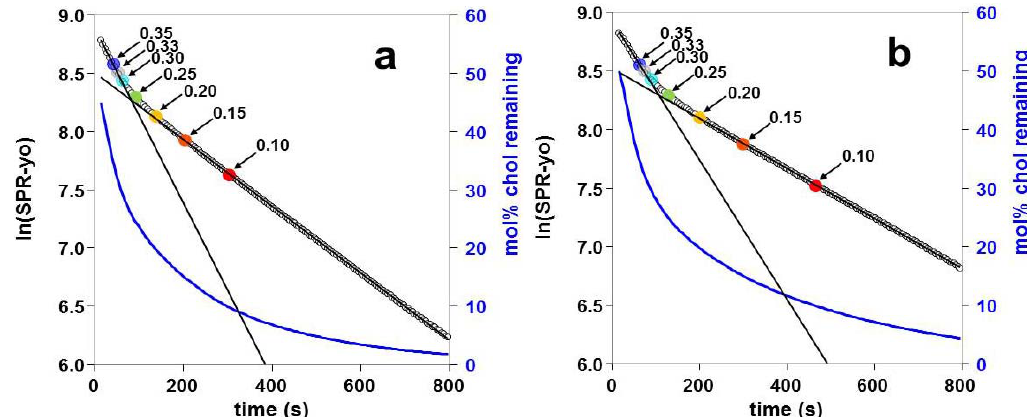
Figure 7. Kinetics of cholesterol removal from ( a ) POPC and ( b ) OPPC liposomes saturated with cholesterol. The half-life times for slow pool cholesterol are 240 s (POPC) is the SPR response with all the cholesterol removed; and 325 s (OPPC). As for Figure 5, y o other terms in the exponential decay equation are as defined above in section 2.3. The calculated mol% of cholesterol remaining in the liposomes is shown by the line in dark blue (see right-hand axis). The calculated χ c remaining in the adsorbed liposomes is indicated on the Figure for the filled colored circles; colors correspond to those in Figure 5. Values used for these Figures represent averages of ten or more experiments; examples for individual experiments are shown in the supplementary